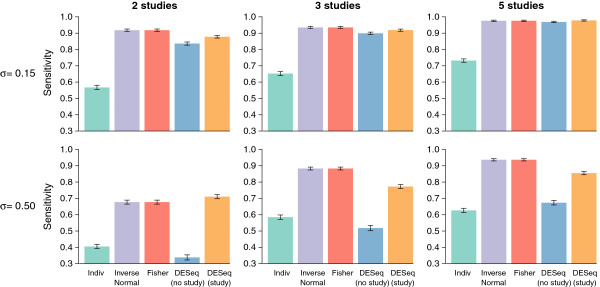
Sensitivity for low and high inter-study variability. Sensitivity, for the simulation settings corresponding to σ=0.15 and σ=0.50. Each barplot represents the results of a particular setting, with columns corresponding (from left to right) to simulations including 2 studies, 3 studies, and 5 studies, and rows corresponding (from top to bottom) to simulations with inter-study variability set to σ=0.15 and σ=0.50 (low inter-study variability to large inter-study variability). Within each barplot, from left to right: Individual per-study analyses (green bars), inverse normal (purple bars), Fisher (red bars), global DESeq with no study effect (blue bars), and global DESeq with a fixed study effect (orange bars).